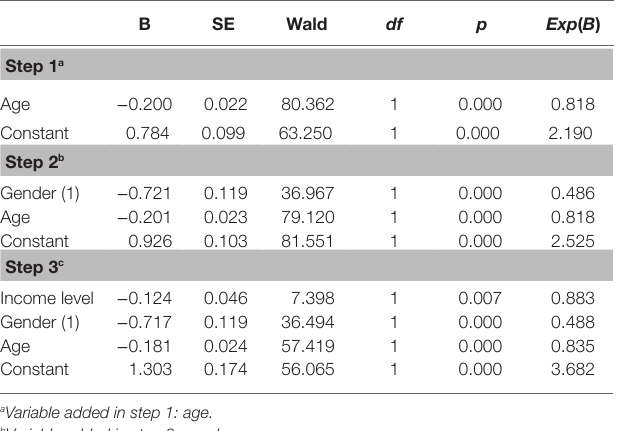
TABLE 3 | Variables in the equation.